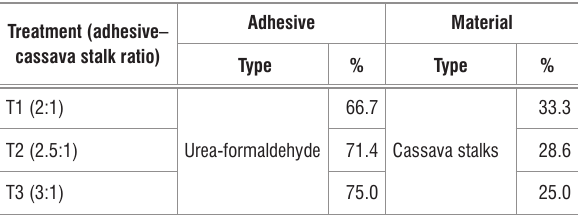
Analysis of variance of the effect of material variables on